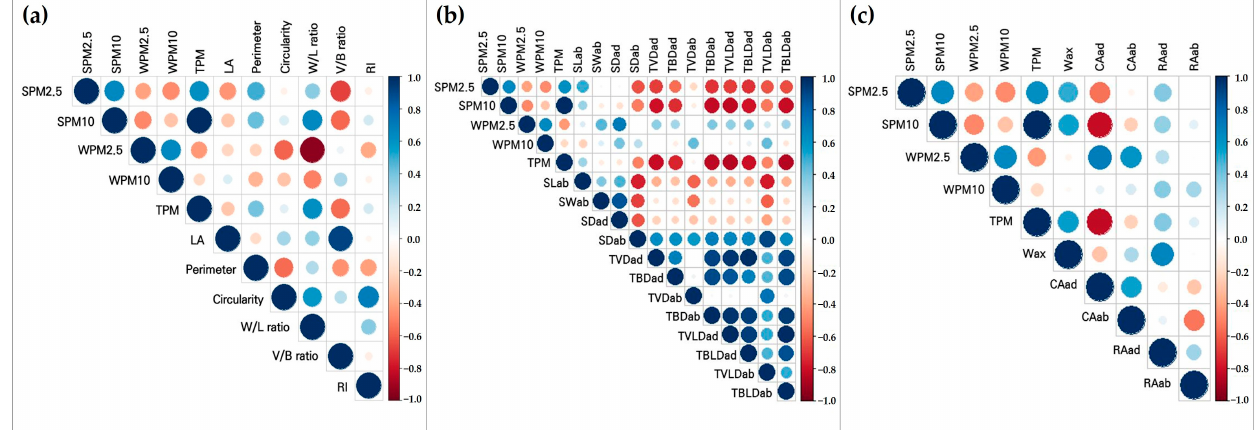
Figure 8. Correlation matrix of leaf structural parameters for ( a ) macro-scale, ( b ) micro-scale, and ( c ) geometric properties in the net PM wash-off ability obtained from the inner crown-positioned leaves during rainfall events in the Seoul Forest Park. Note: The color of the spectrum bar represents the correlation between two variables; red signifies a negative correlation and blue denotes a positive correlation. The correlations are proportional to the color saturation and circle size. A small circle displays a weak correlation, while the blue diagonal denotes autocorrelation.